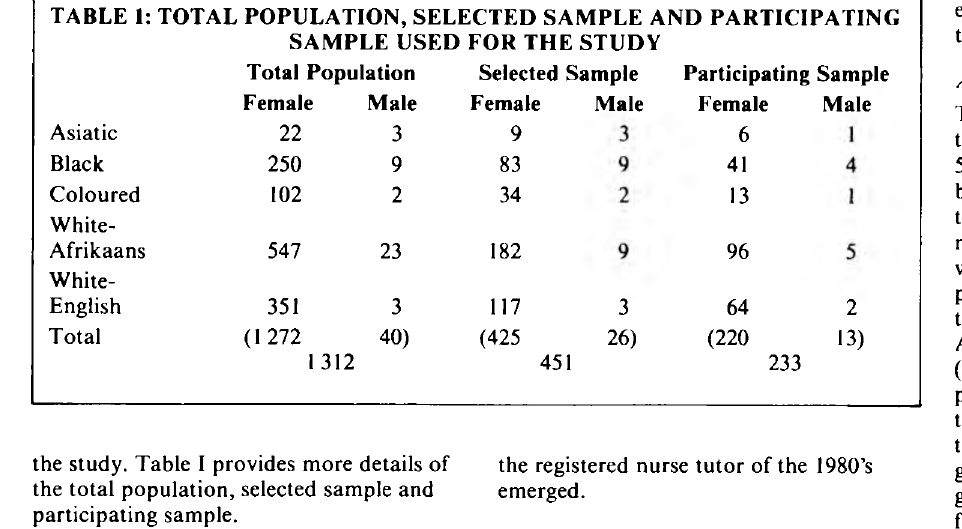
TABLE 1: TOTAL POPULATION, SELECTED SAMPLE AND PARTICIPATING